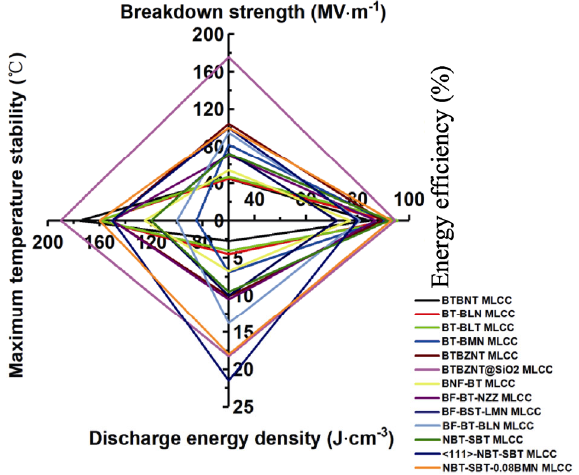
Fig. 34 Comprehensive energy-storage performance of